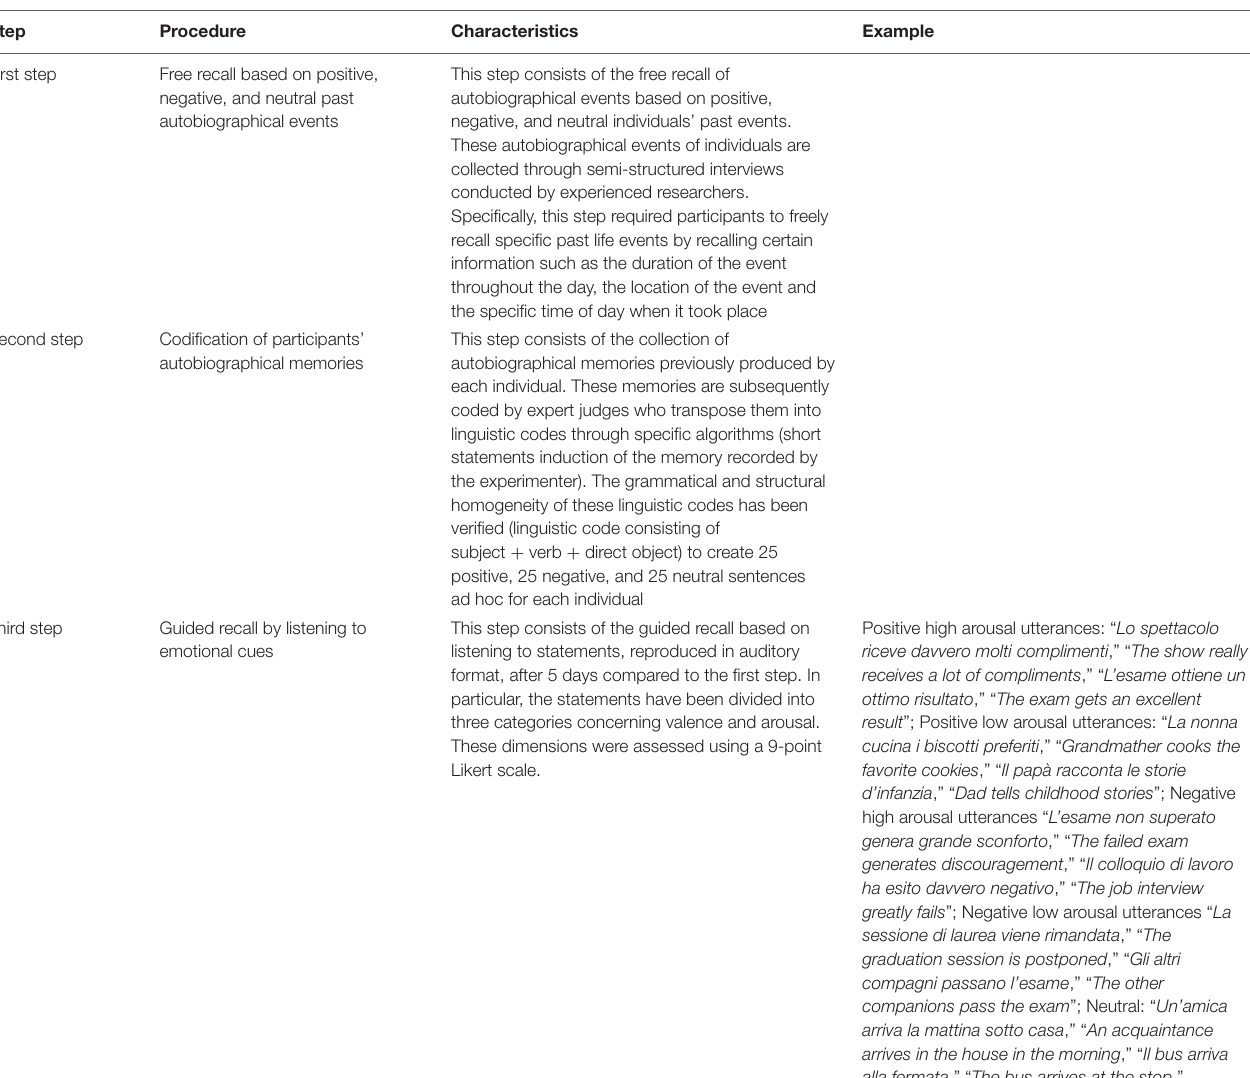
TABLE 1 | Procedural steps for the creation of the EM